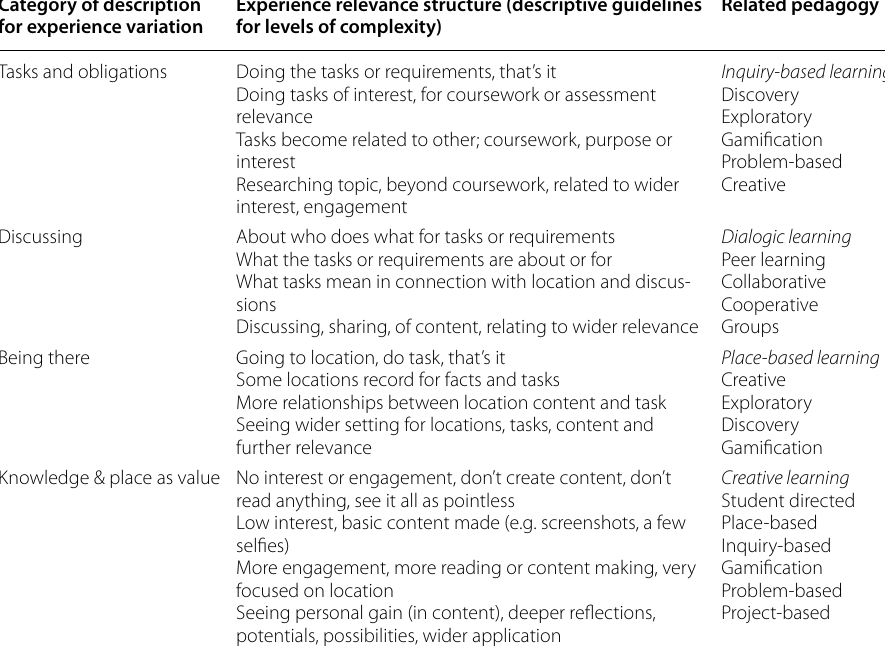
Table 2 Summary of experience relevance structures and related pedagogies in a smart learning journey (Lister, 2021b) Category of description for experience